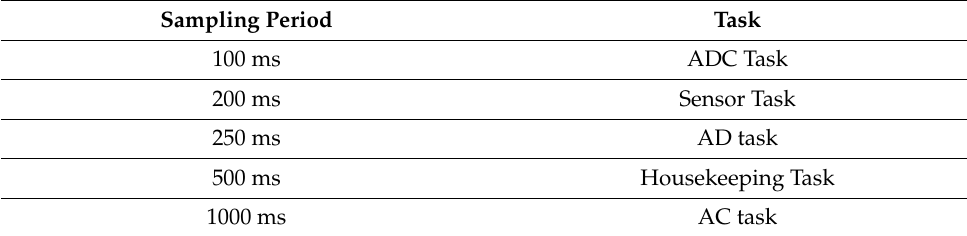
Table 1. ADCS DSP